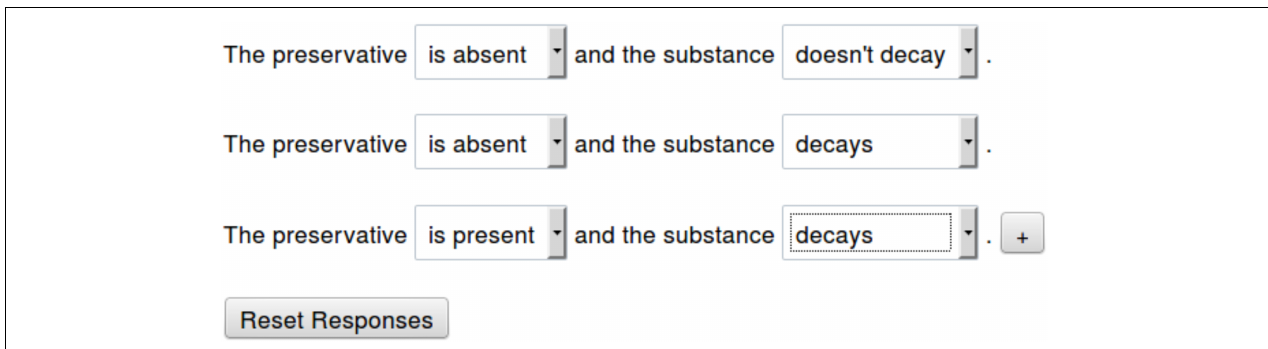
FIGURE 3 | The interface used to elicit responses in Experiment 3. Participants completed sentences using drop-down menus and added possibilities using a button marked “+.”